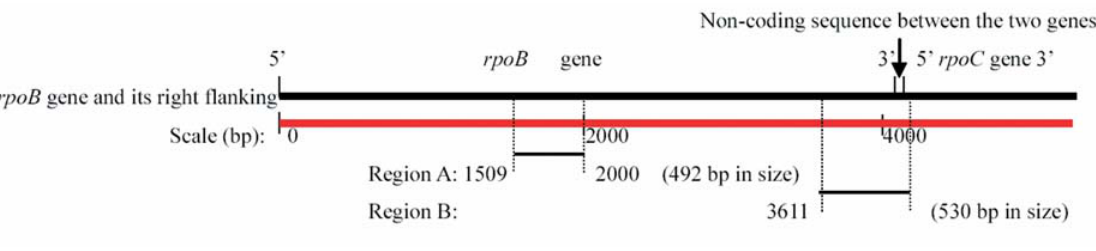
Figure 2 - Sketch map showing the high-fidelity PCR amplification